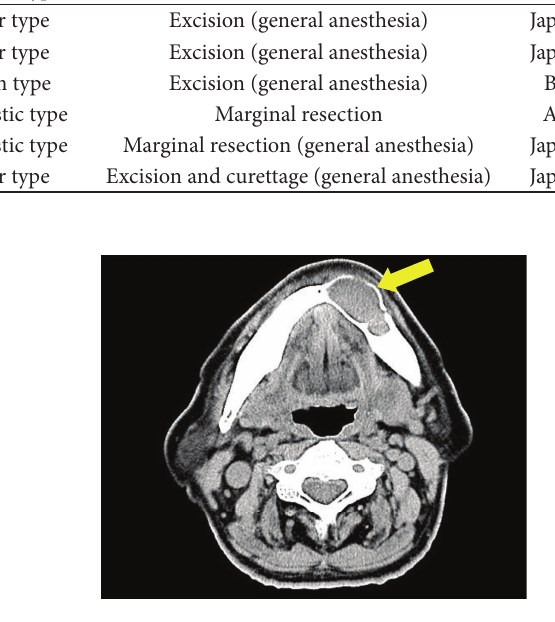
Figure 3: Computed tomography view. This shows thinning of peripheral bone was observed, with the bone lacking continuity in some